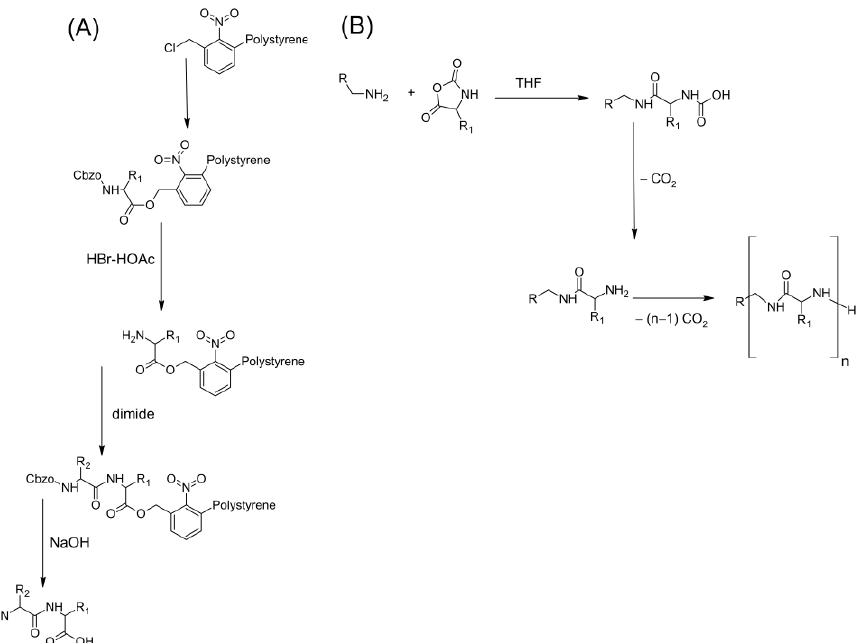
Figure 9. Peptide synthesis ( A ) Concept of the Solid Phase Peptide Synthesis; ( B ) by ROP of α -aminoacid-N-carboxyanhydrides with the use of amine initiator.